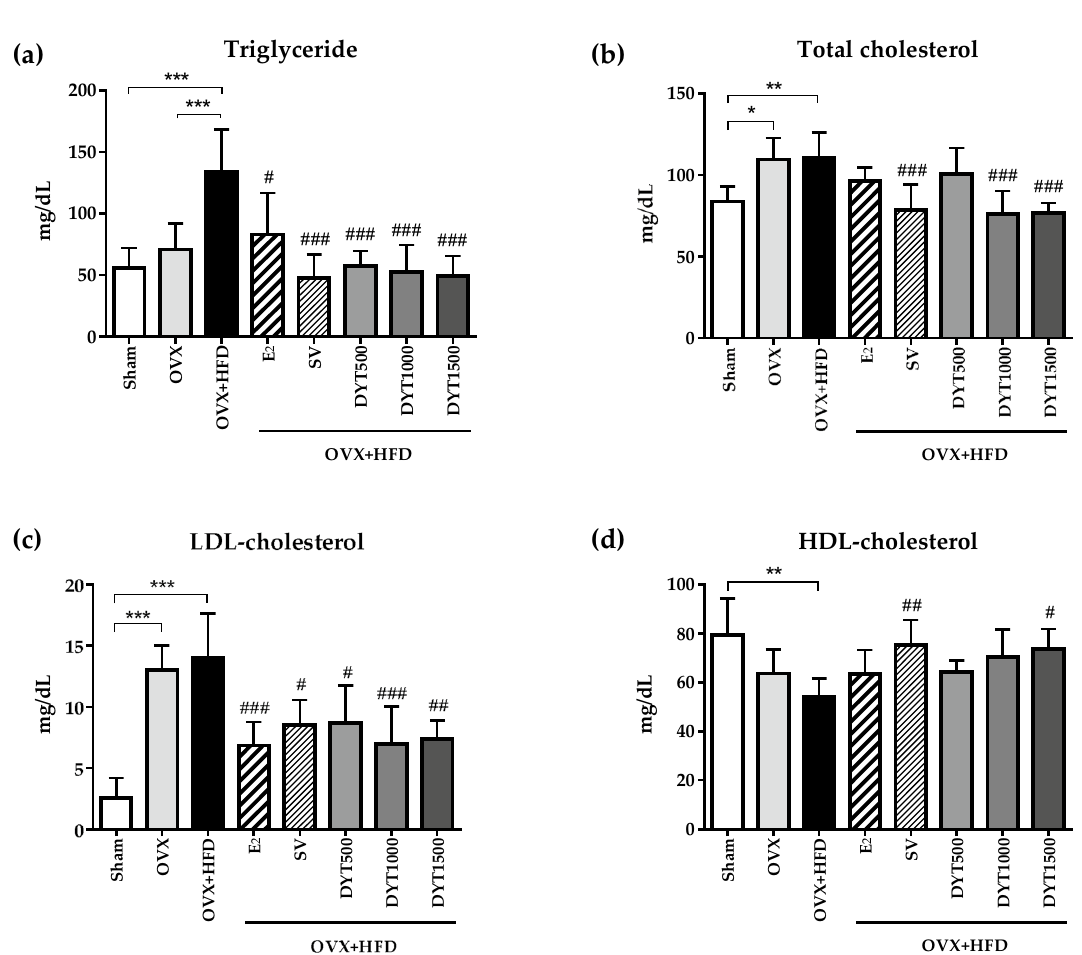
Fig. 5 Effect of DYT on the serum lipid profile in ovariectomized high‑fat diet animal model. Triglyceride ( a ), total cholesterol ( b ), LDL‑cholesterol ( c ), and HDL‑cholesterol ( d ) were measured using a competitive enzyme‑linked immunosorbent assay, and data was analyzed using software PRISM (Graphpad; CA, USA). Data are presented as mean SD (n 7). * p < 0.05, ** p < 0.01, *** p < 0.001 vs. sham or OVX group., # p < 0.05, ## p < 0.01, ### ± = p < 0.001 vs . OVX HFD +